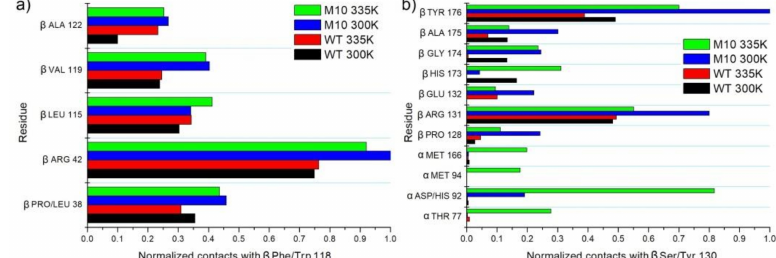
Figure 13. ( a ) Interactions of β Phe / Trp118 with neighbor amino acids. ( b ) Interactions of β Ser / Tyr130 with neighbor amino acids.